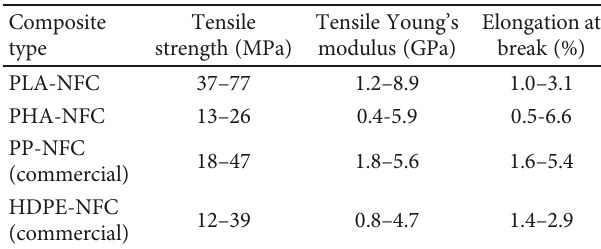
Table 1: Range of tensile properties of NFCs made with a biodegradable polymer compared to commercial PP and PE- based NFCs (with a wood fi ller content of 30 – 50wt %), adapted from [4,